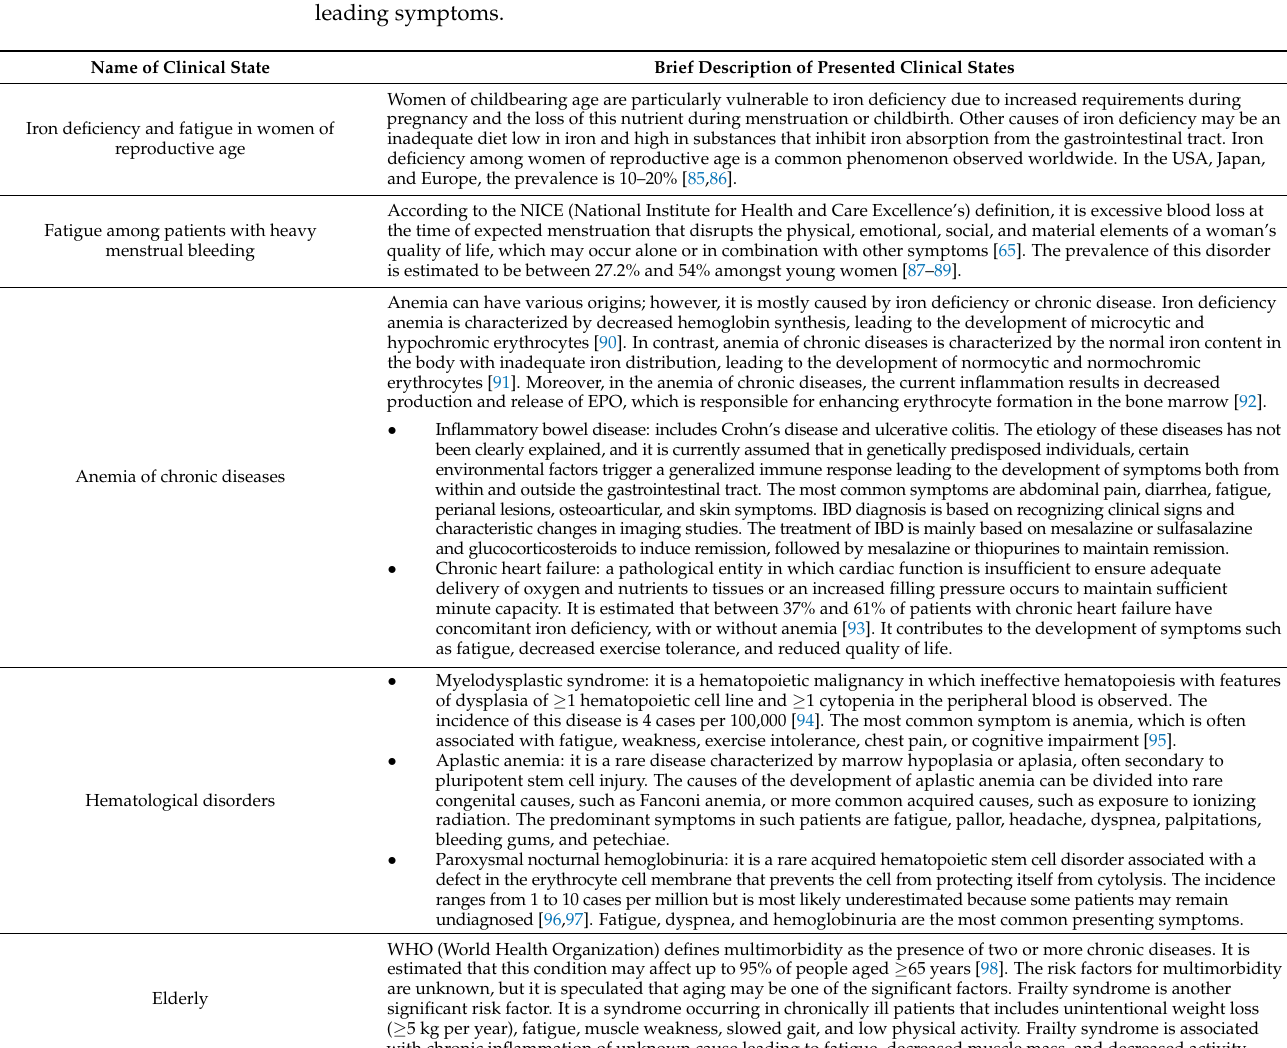
Table 4. The iron deficiency clinical conditions discussed in the article with fatigue as one of the leading